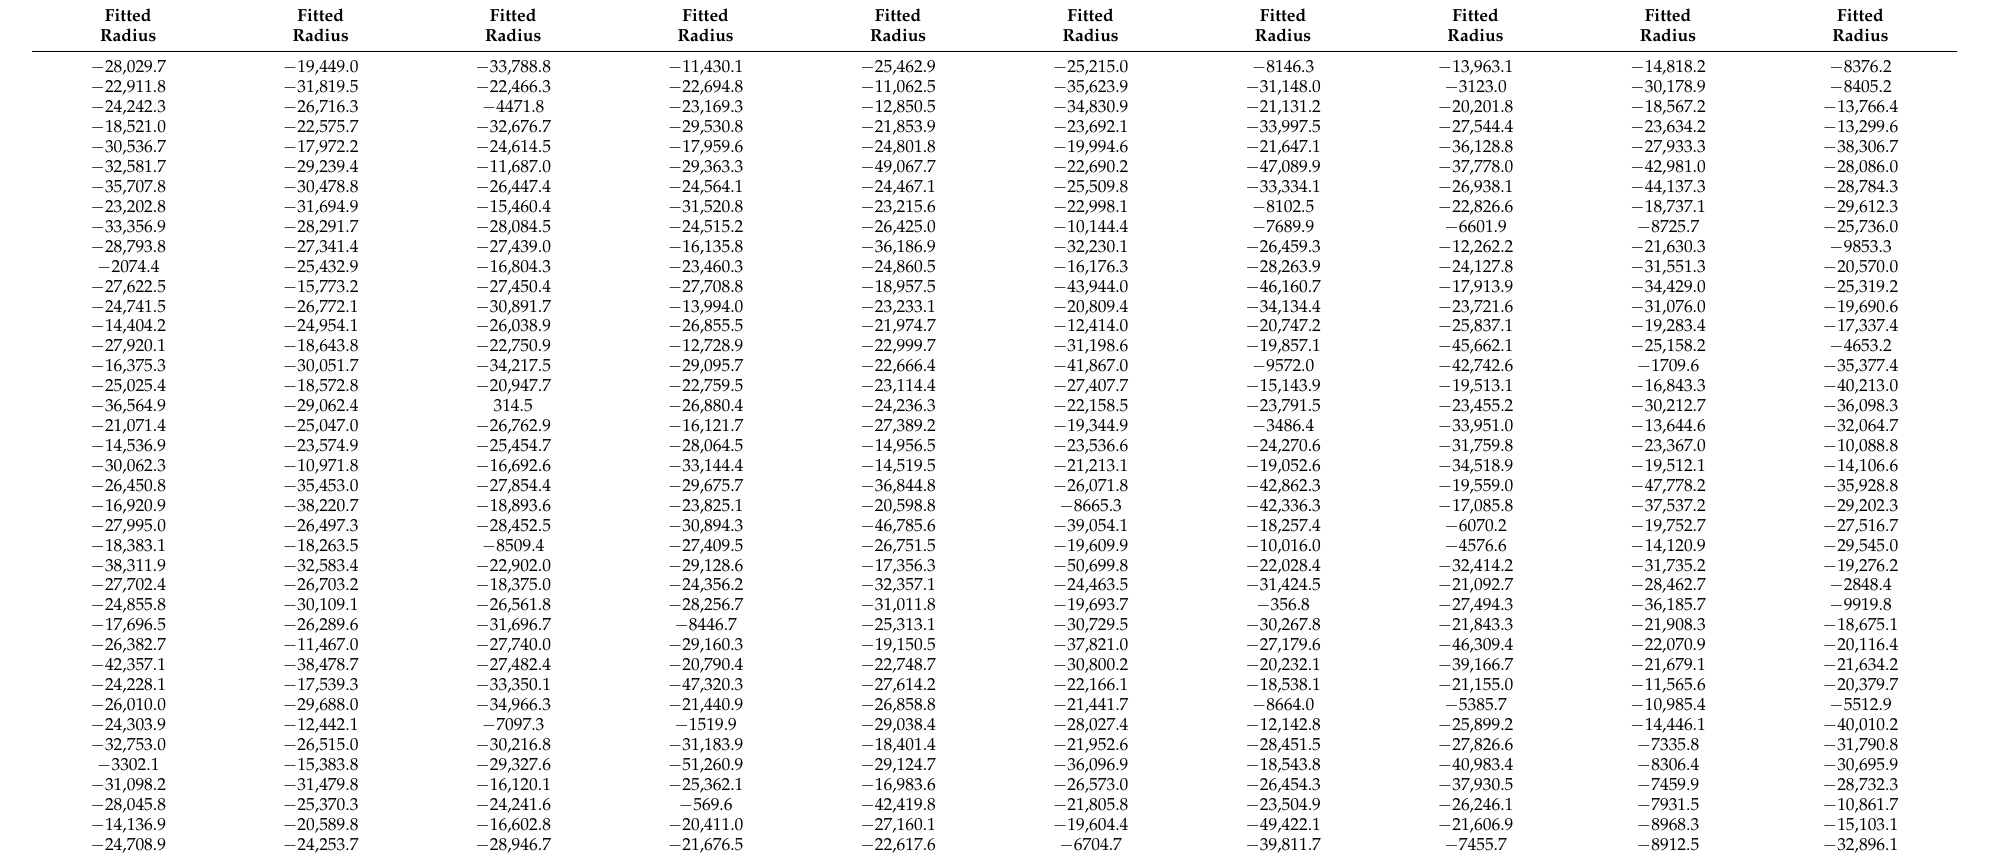
Table A4. Fitted radius of forward-moving trajectory